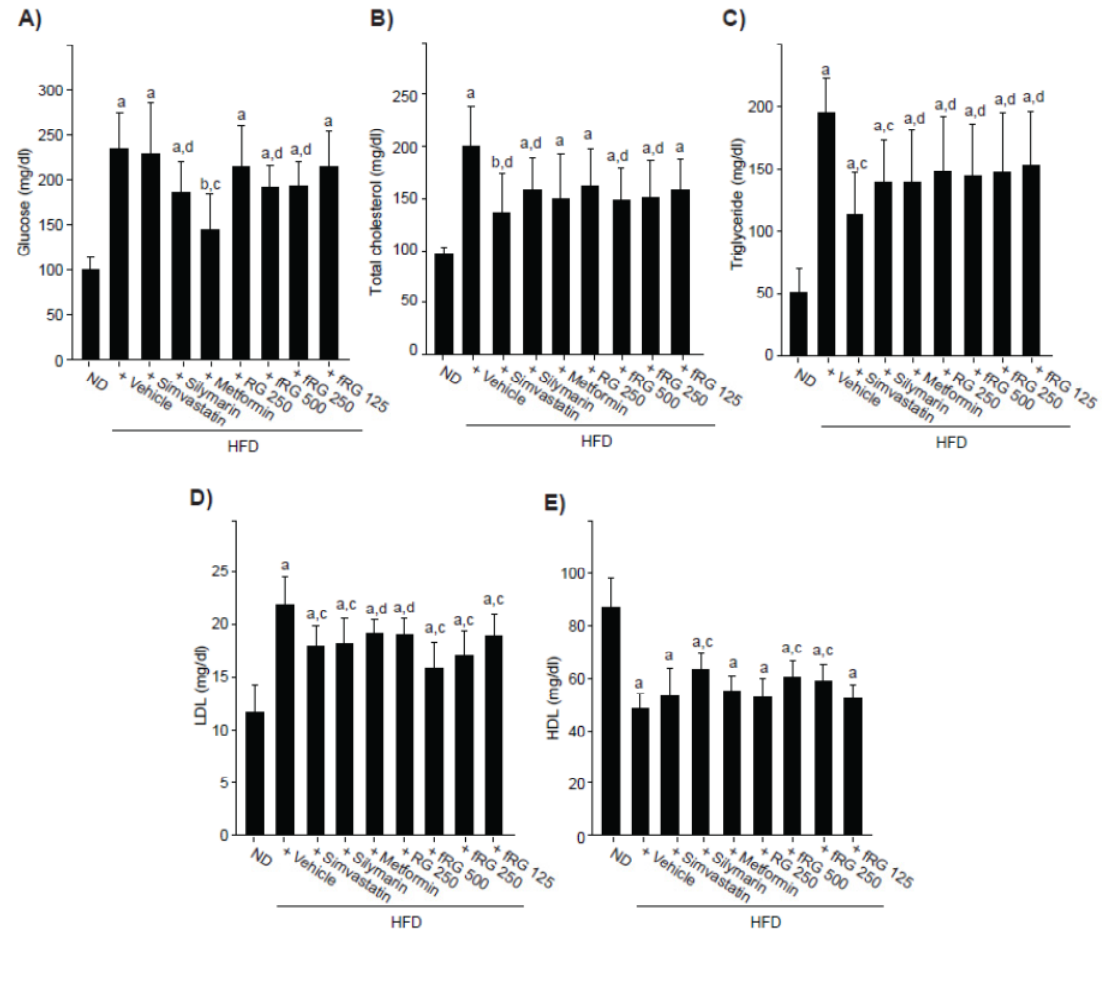
Figure 3. Effect of fRG on the level of serum glucose and lipid profile. The glucose ( A